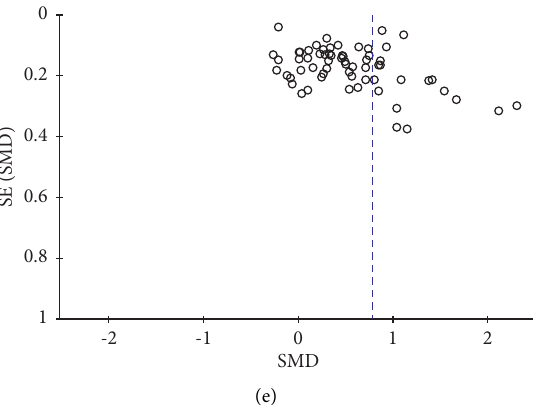
Figure 3: (a) Forest plot of subclinical hypothyroidism and uric acid. (b) Subgroup analysis of subclinical hypothyroidism, grouped by area. (c) Subgroup analysis of subclinical hypothyroidism, grouped by age. (d) Subgroup analysis of subclinical hypothyroidism, grouped by basic diseases. (e) Funnel plot of subclinical